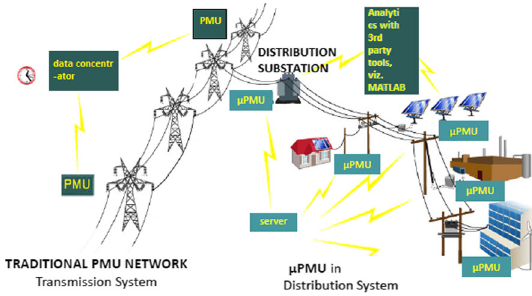
Fig. 1 PMU deployment structure [14]